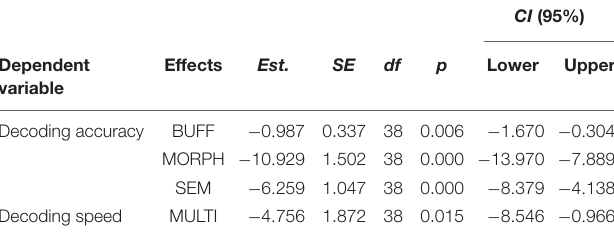
TABLE 3 | Significant random effects of percent decoding errors on standard measures of decoding accuracy and speed.